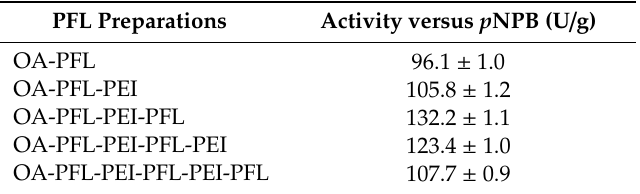
Table 1. Mass activity of different PFL biocatalysts in hydrolysis of 1 mM p -nitrophenyl butyrate ( p NPB) at 25 °C at pH 7. Experiments were performed as described in Methods. The loading of each layer as fairly similar, around 60–65 mg of protein/g of octyl agarose.